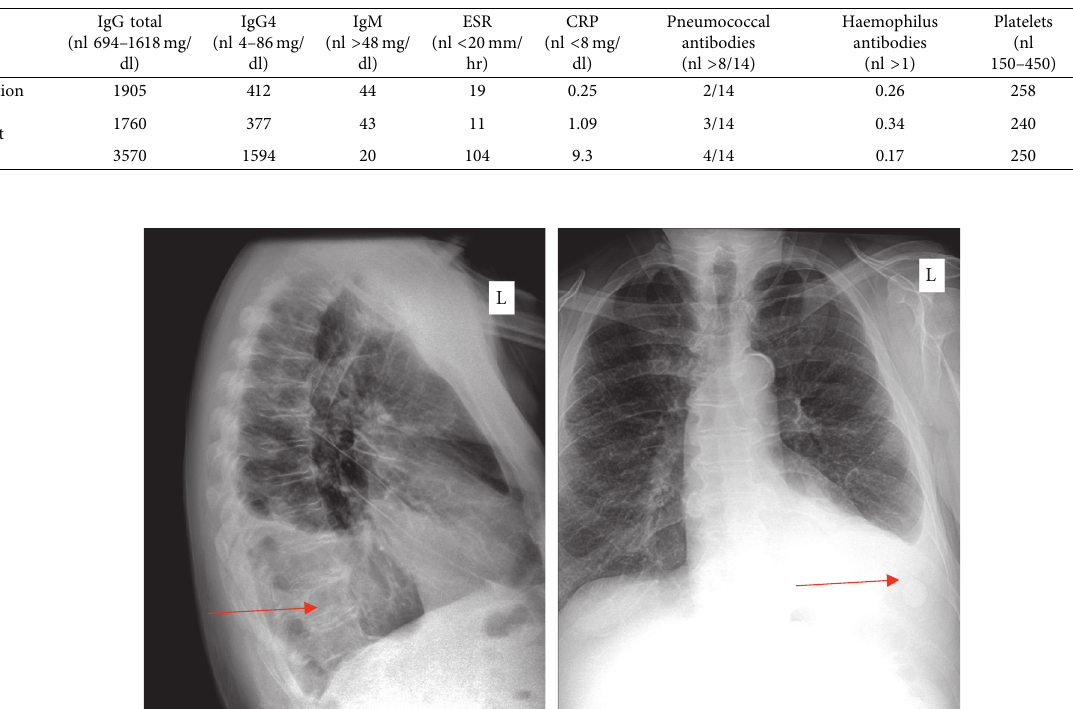
Figure 1: Lateral and posterior-anterior chest X-ray showing left-sided pleural effusion (arrows) during symptom